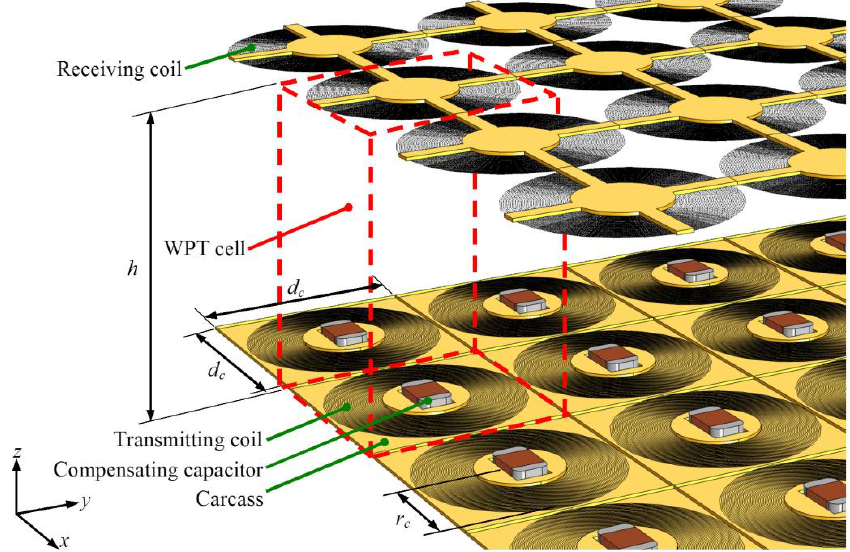
Figure 1. Periodic WPT system combined with an array of WPT cells.